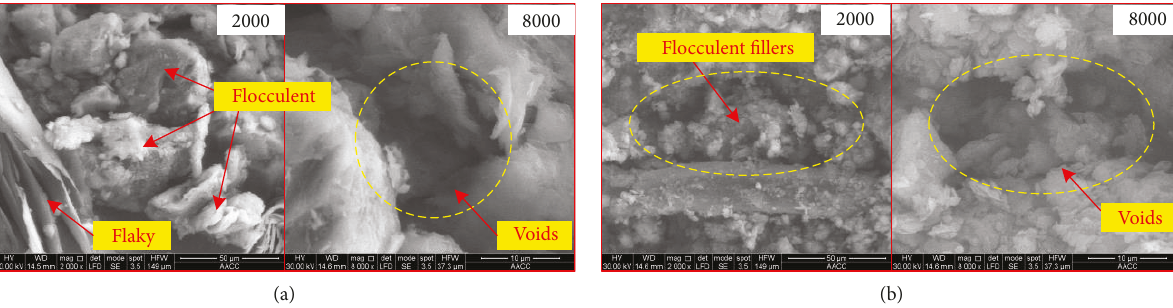
Figure 5: Microstructures of specimens obtained using SEM at di ff erent magni fi